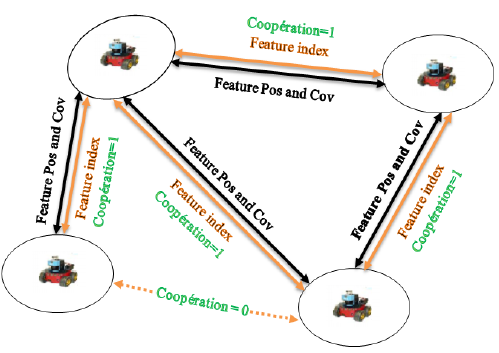
Fig. 3: ACI Decentralized Cooperative VSLAM strat-